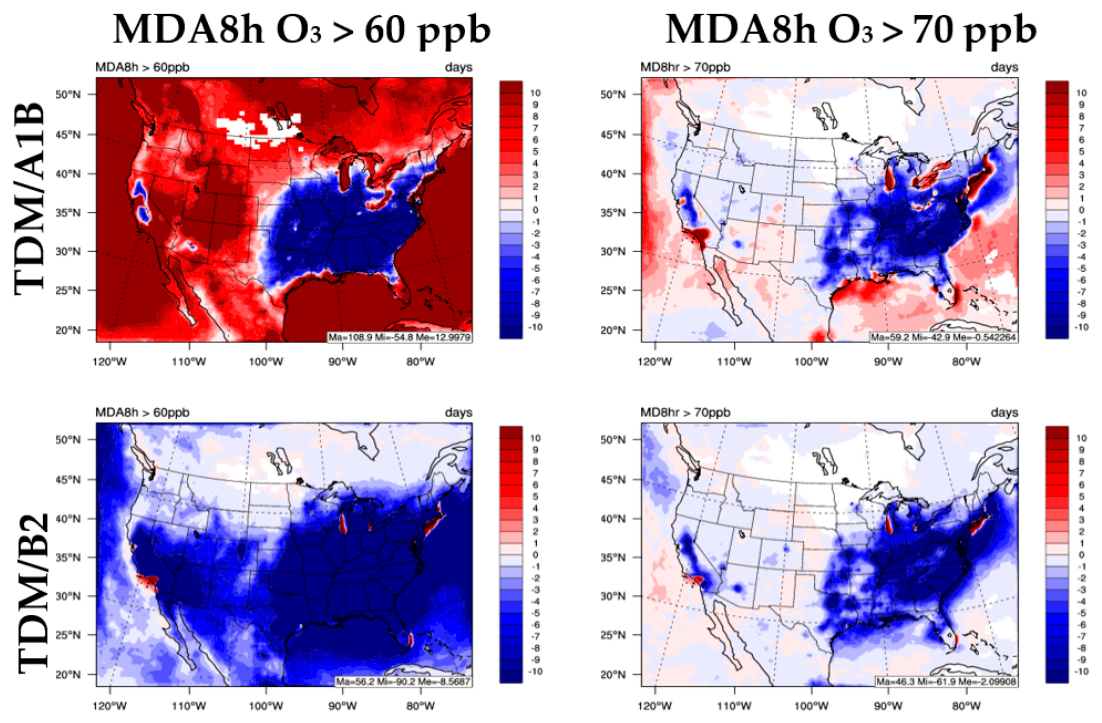
Figure 5. Absolute changes of average number of exceedance days of MDA8 h O 3 with a threshold of 60 ppb and 70 ppb between the future and current decade for TDM/A1B and TDM/B2.